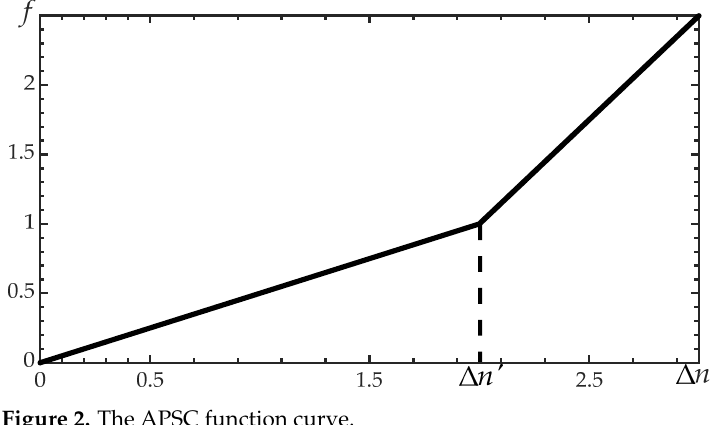
Figure 2. The APSC function curve.